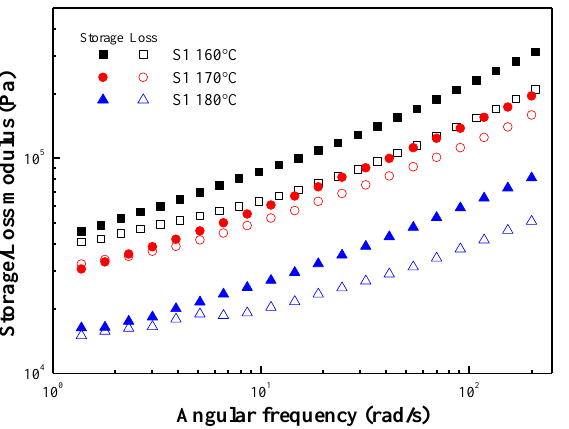
Figure 7. Frequency-dependent storage modulus (closed symbols) and loss modulus (open symbols) of S1 at various temperatures.